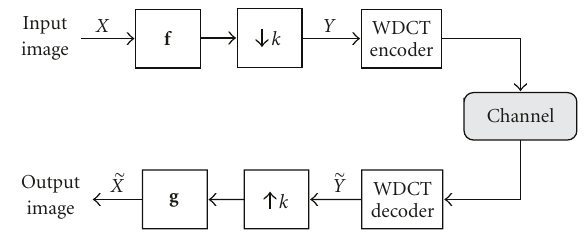
Figure 1: WDCT-based low bit-rate block coding using image